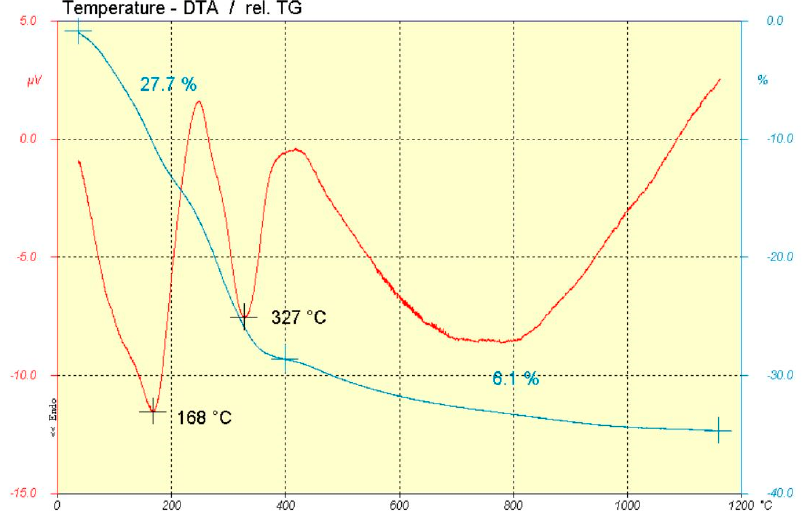
Figure 2. DTA (red line) and TG (blue line) of HTLC sample.